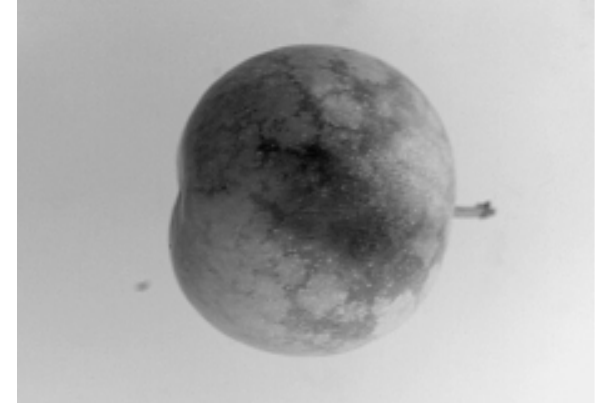
Fig. 1. Fruits of plum cv. Florentia showing the typical discoloured spots forming a net-like pattern on the skin.